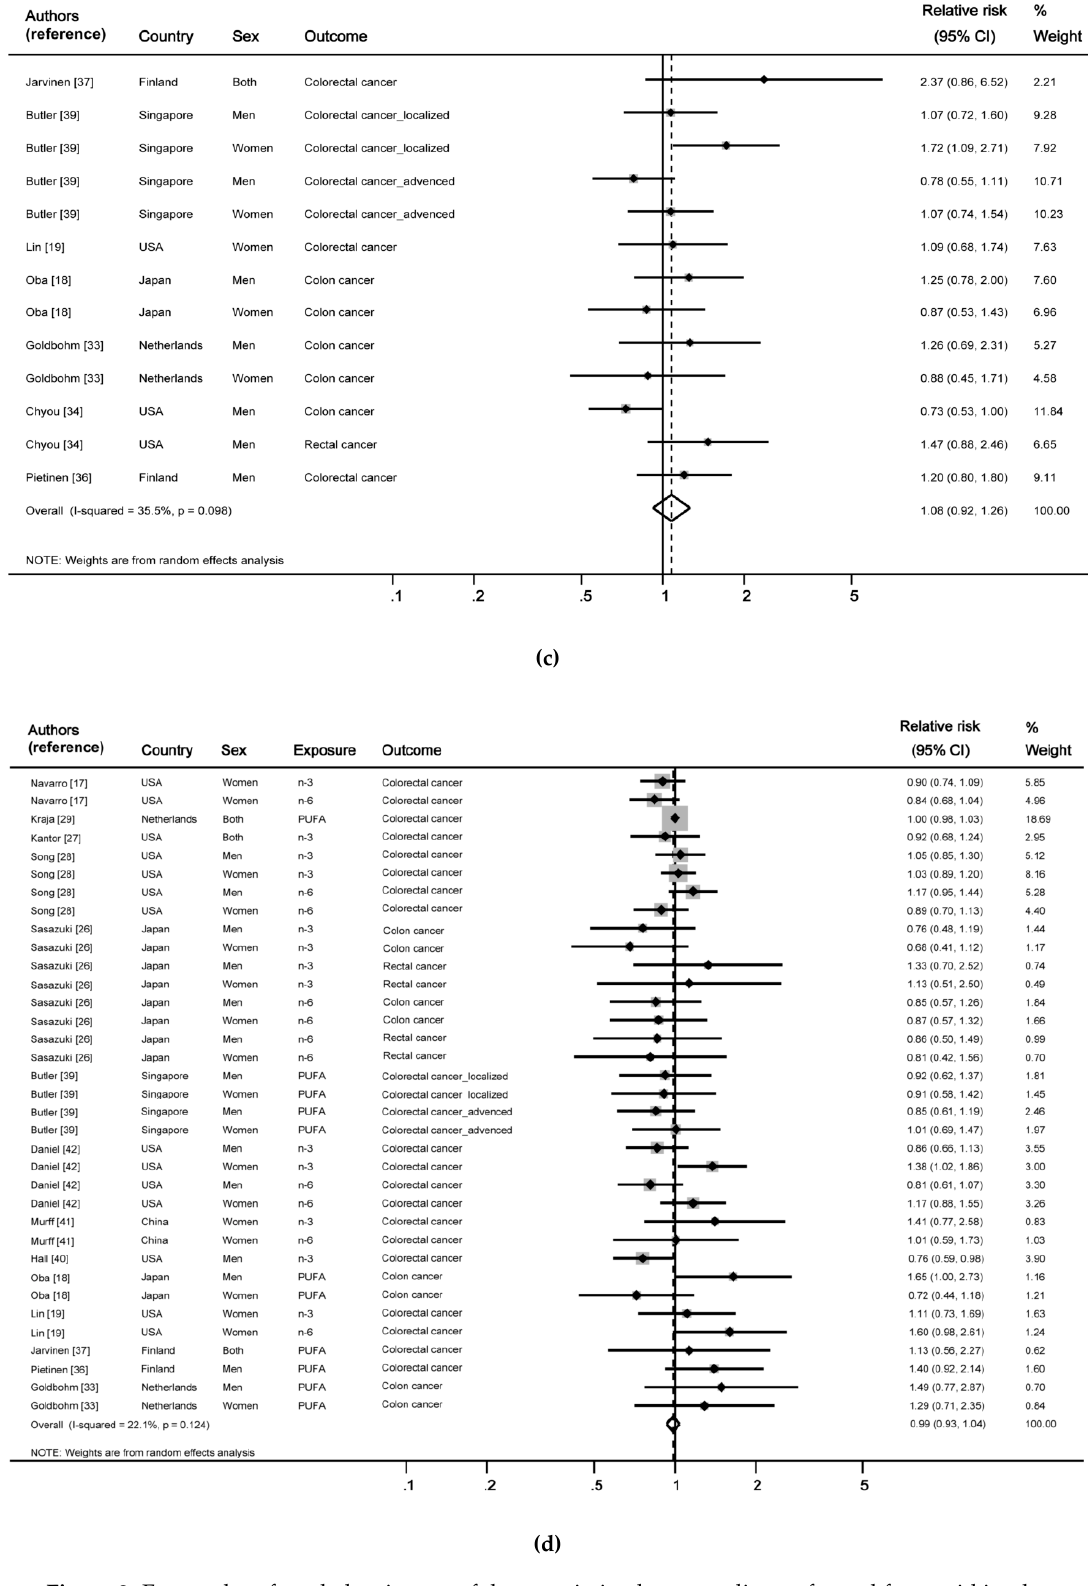
Figure 2. Forest plot of pooled estimates of the association between dietary fat and fatty acid intake and risk of colorectal cancer. ( a ) Total fat intake and risk of colorectal cancer; ( b ) saturated fat or fatty acid and colorectal cancer; ( c ) monounsaturated fat or fatty acid and colorectal cancer; and ( d ) polyunsaturated fat or fatty acid and colorectal cancer. CI, confidence interval; n-3, omega-3 fatty acids; n-6, omega-6 fatty acids.